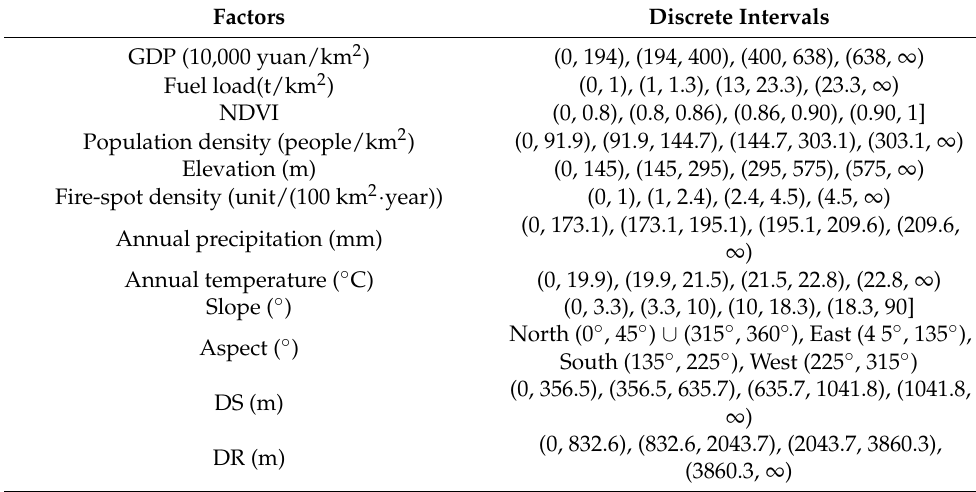
Table 3. Factor discretization